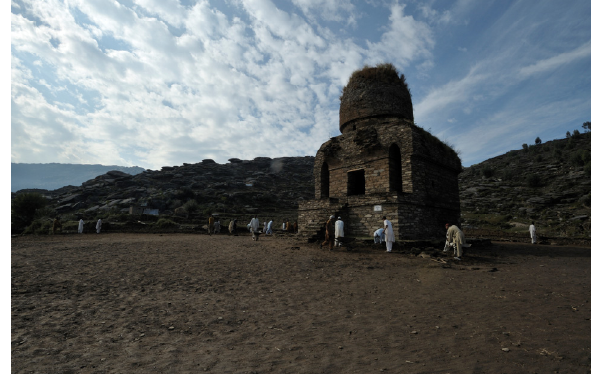
Figure 4 . The shrine before excavation after preliminary restoration (2011). View from